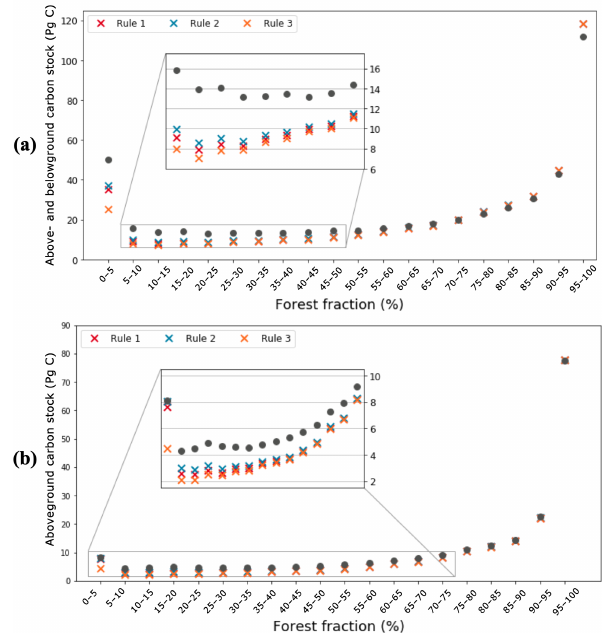
Figure 9. Total carbon stock grouped by forest fraction from the averaged satellite-based forest cover map. (a) Global (above- and belowground); (b) pantropical